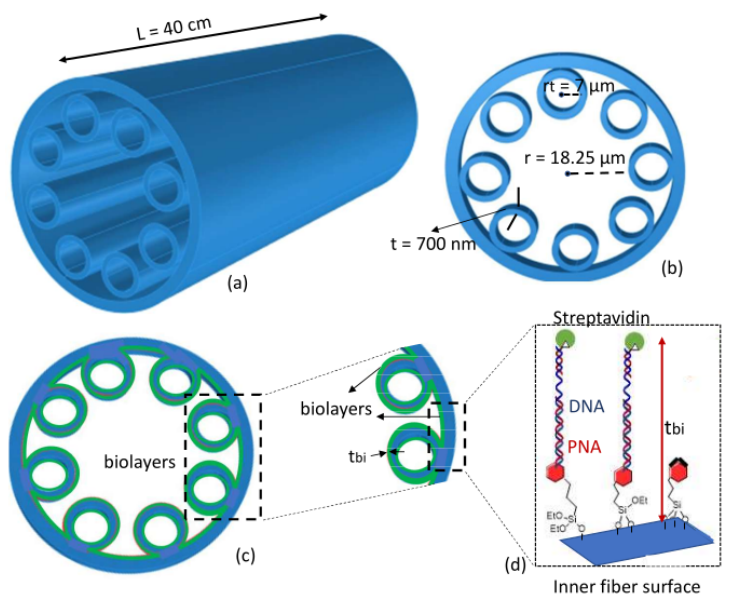
Figure 1. Schematics of ( a ) HCTLF-based biosensor with L = 40 cm, ( b ) fiber cross-section view with structural parameters, ( c ) Sensing mechanism and formation of the bio-layers inside the fiber surfaces, and ( d ) details about formation of the bio-layers, bioreceptors and streptavidin